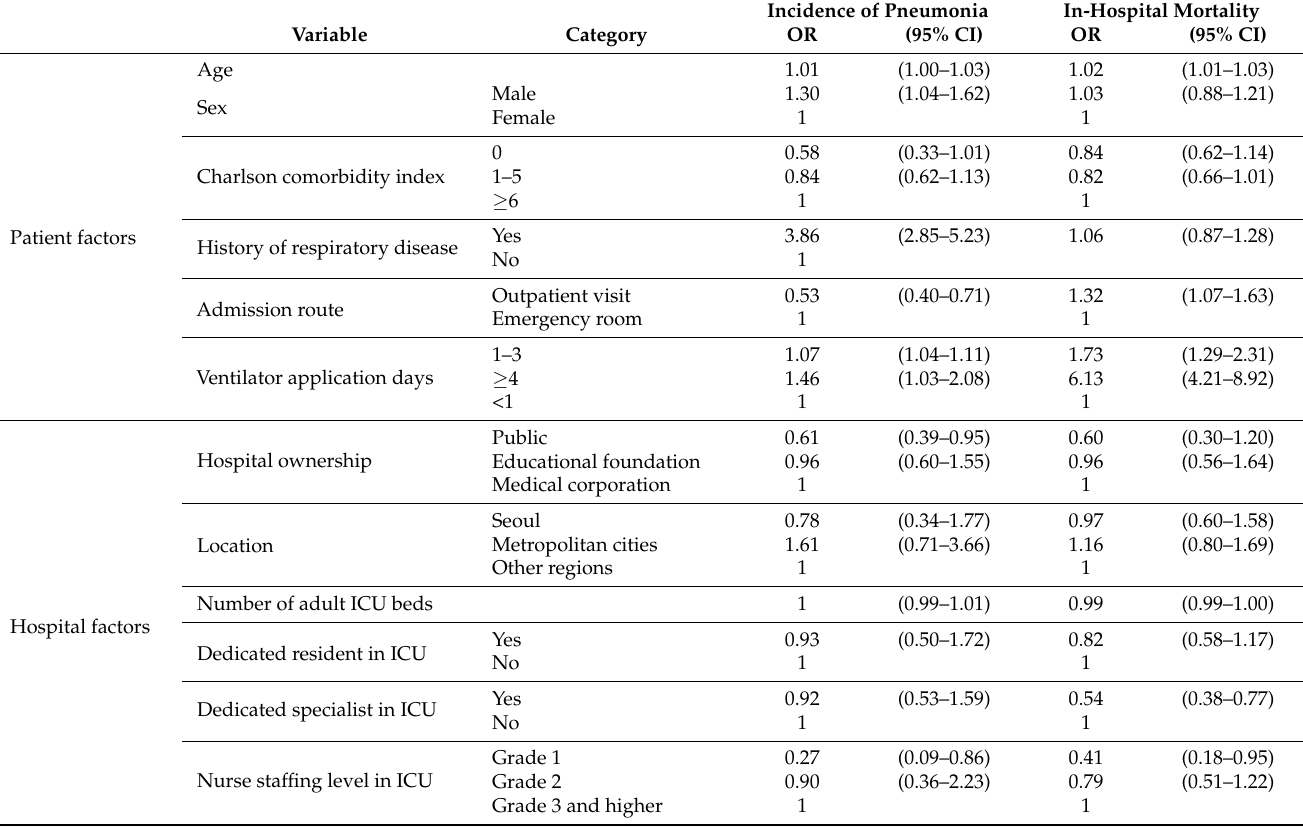
Table 6. Logistic regression analysis of hospital-acquired pneumonia and in-hospital